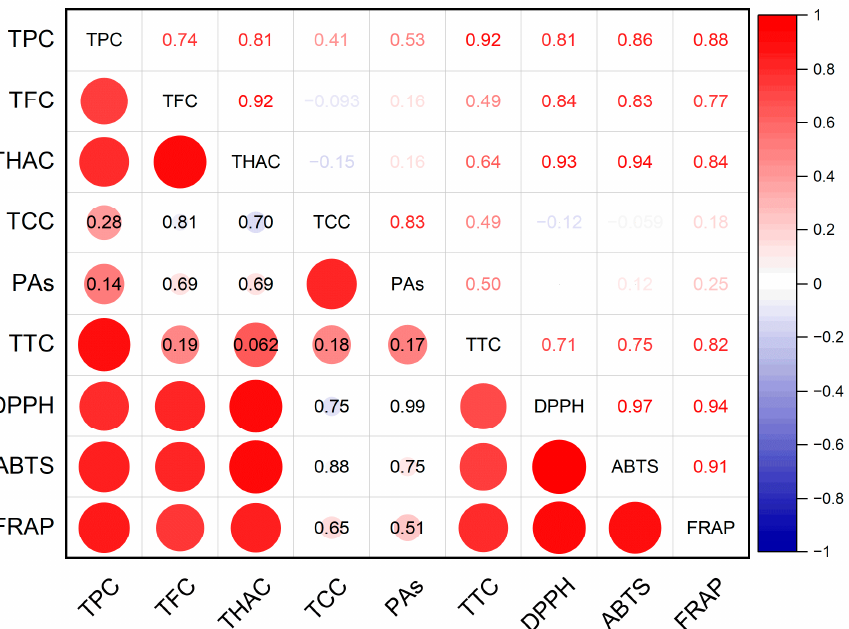
Figure 1. Pearson correlation coefficients between phenolic compounds and antioxidant activity of extracts. TPC—total phenolic content; TFC—total flavonoid content; THAC—total hydroxycinnamic acid content; TCC—total catechin content; PAs—total proanthocyanidin content; TTC—total tannin content; DPPH—antioxidant activity determined by DPPH (2,2-diphenyl-1-picrylhydrazyl) assay; ABTS—antioxidant activity determined by ABTS (2,2 (cid:48) -azino-bis(3-ethylbenzothiazoline-6-sulfonic acid)) assay; FRAP—ferric-reducing antioxidant